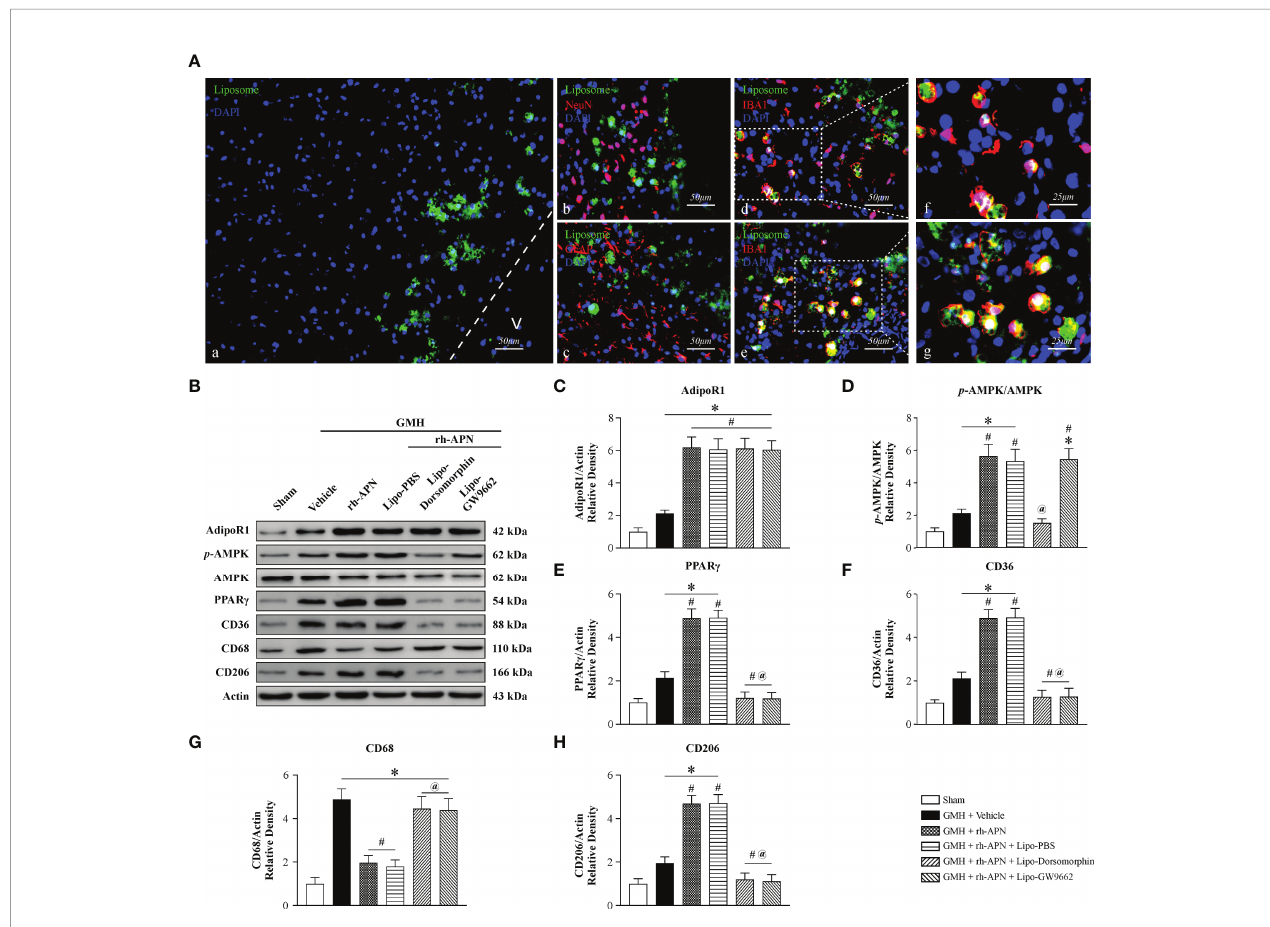
FIGURE 8 | Selective inhibition of AMPK/PPAR g signaling in activated microglia cells abolished the effect of rh-APN on inhibiting neuroin fl ammation and promoting hematoma resolution 72 hours after GMH (A) Representative images of immuno fl uorescence staining showing fl uorescent dye-labeled liposomes (A , green ) were swallowed almost entirely in microglia D, E (Iba1 + , red) rather than in Neurons (B) (NeuN + , red) and Astrocytes (C) (GFAP + , red) at 72 h after GMH. (B) Representative images of Western blot data showing the expression of p-AMPK, PPAR g and CD36, as well as CD68 and CD206 either with rh-APN treatment alone, rh-APN + Lipo- Dorsomorphin or rh-APN + Lipo-GW9662. (C) No changes observed in the expression of AdipoR1 with Lipo-Dorsomorphin and Lipo-GW9662 intervention. (D) Western blot analysis of p-AMPK to AMPK ratio showed p-AMPK increased in the rh-APN treatment group and decreased in Lipo-Dorsomorphin group. (E, F, H) Western blot data showed (E) PPAR g , (F) CD36 and (H) CD206 expression increased with rh-APN treatment but decreased in Lipo-Dorsomorphin and Lipo-GW9662 groups. (G) Western blot data showed that rh-APN signi fi cantly decreased CD68 expression, whereas Lipo-Dorsomorphin and Lipo-GW9662 reversed the inhibitory effect of rh-APN. (All samples of GMH + rh-APN in Western blot were from the same animals which were euthanized after short-term neurobehavioral tests). Values are expressed as mean ± SD. ANOVA, Dunnett. n = 6 for each group. * P < 0.05 compared to sham, # P < 0.05 compared to GMH + Vehicle, @ P < 0.05 compared to GMH + rh-APN or GMH + rh-APN +